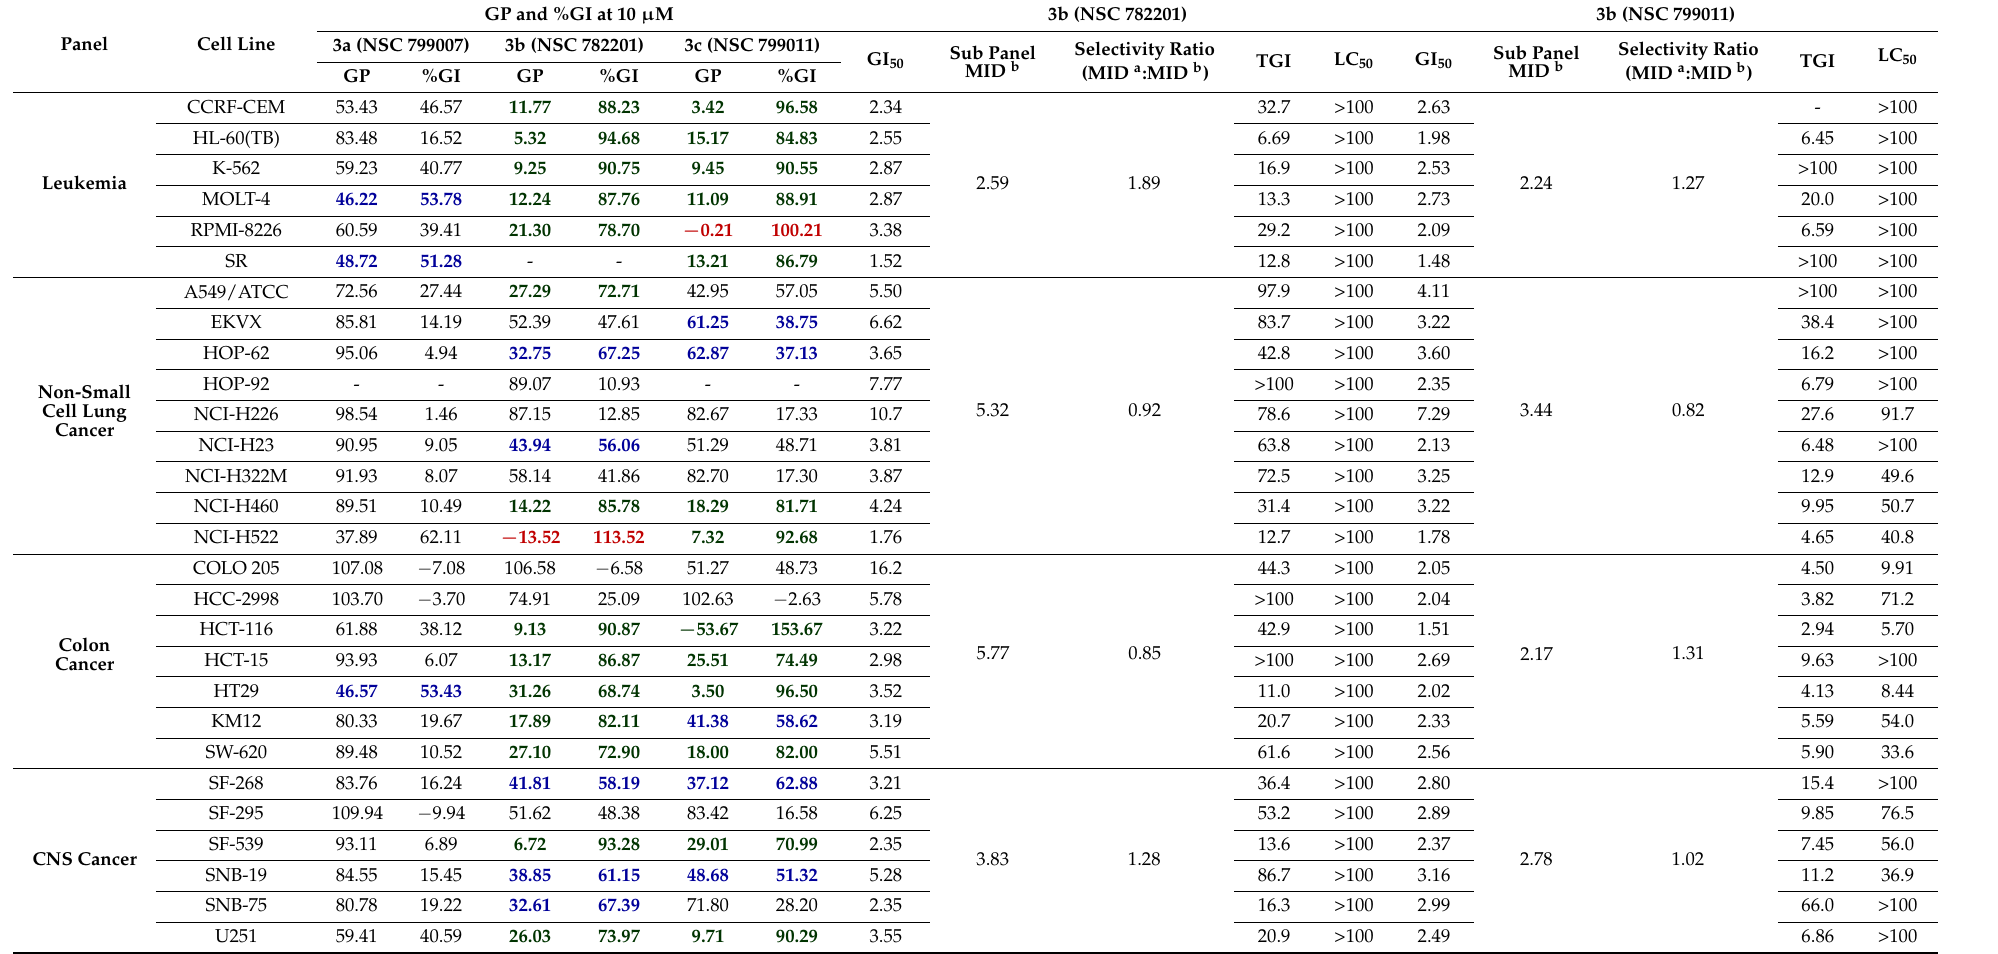
Table 2. The antiproliferative activity of compounds 3a – c in one dose (at 10 µ M) and 5-dose assay (0.01 to 100 µ M) against 60 NCI cancer cell lines.